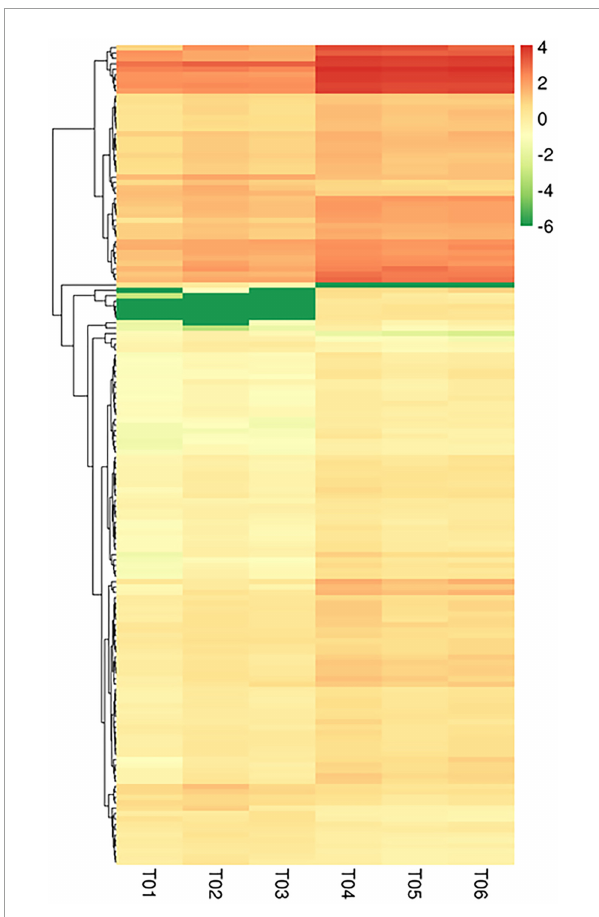
FIGURE3 Cluster analysis of DEGs. Columns represent samples and rows represent different genes. The color represents the expression level of the gene in the sample determined by log10 (FPKM +